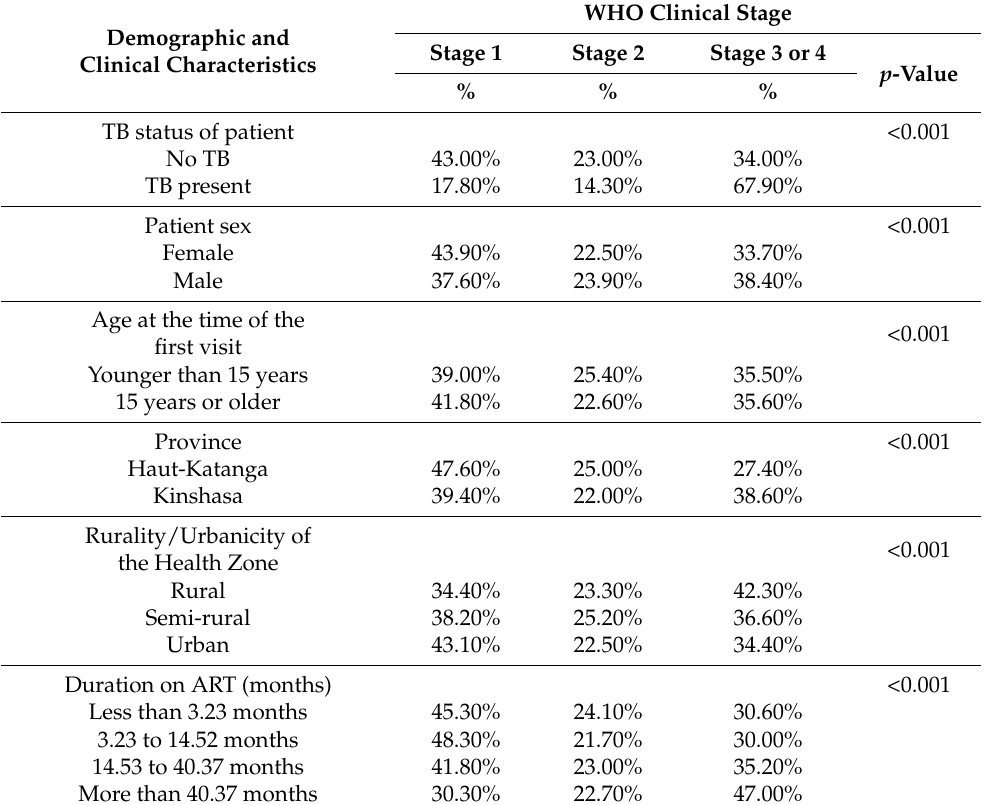
Table 2. Bivariate association between demographic/clinical characteristics and WHO clinical stage among patients in HIV/AIDS clinics of Haut-Katanga and Kinshasa provinces, Democratic Republic of Congo, 2014–2019. Demographic